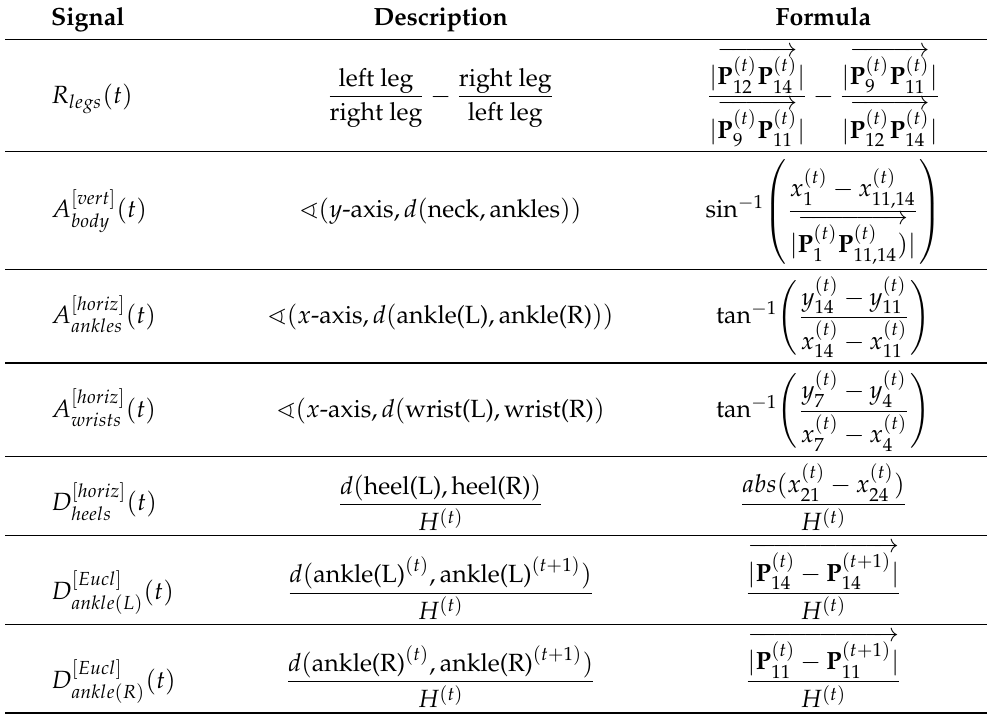
Table 1. Summary of signal computation. The first column denotes the symbol used for each signal, the second column gives a brief non-rigorous description of each signal and the third column lists the exact formula used to calculate the value of a signal on frame t . P body key-point i at frame t , i.e., a pair of values ( x right wrist = 4, left wrist = 7, right hip = 9, right ankle = 11, left hip = 12, left ankle = 14, left heel = 21, right heel = 24. L and R denote the left and right side, respectively, H ( t ) denotes the estimated height of the patient (see Supplement), d denotes a distance function, (cid:94) denotes an angle. Signal Description Formula R legs ( t